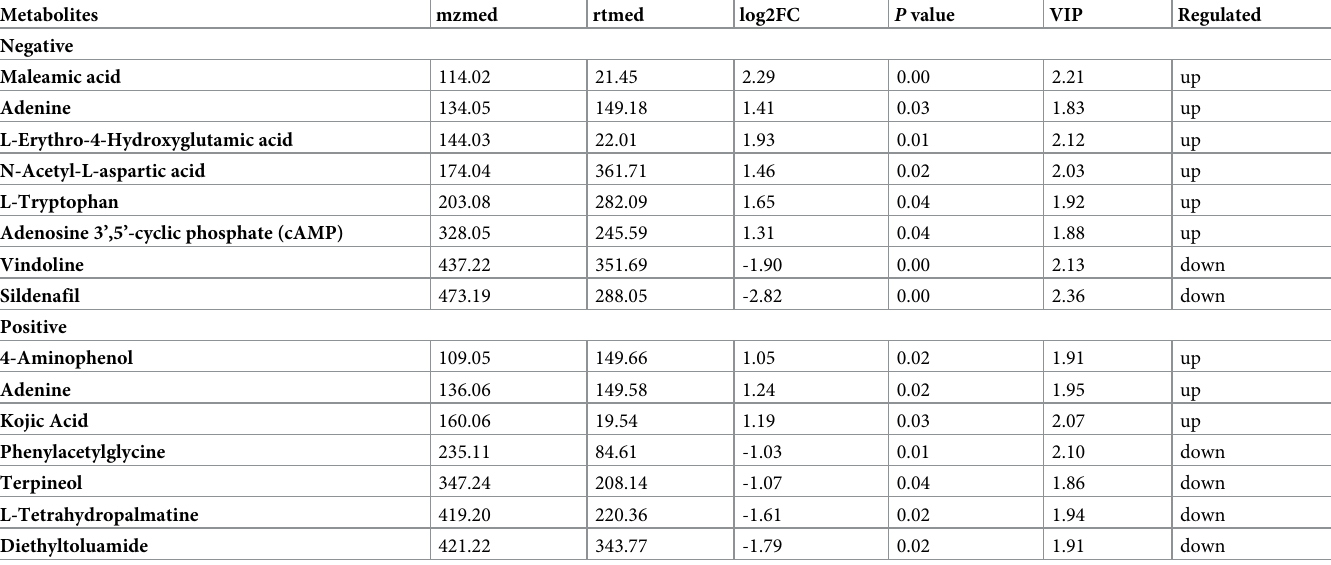
Table 7. Differential metabolites in the rumen of calves fed OP and SP.